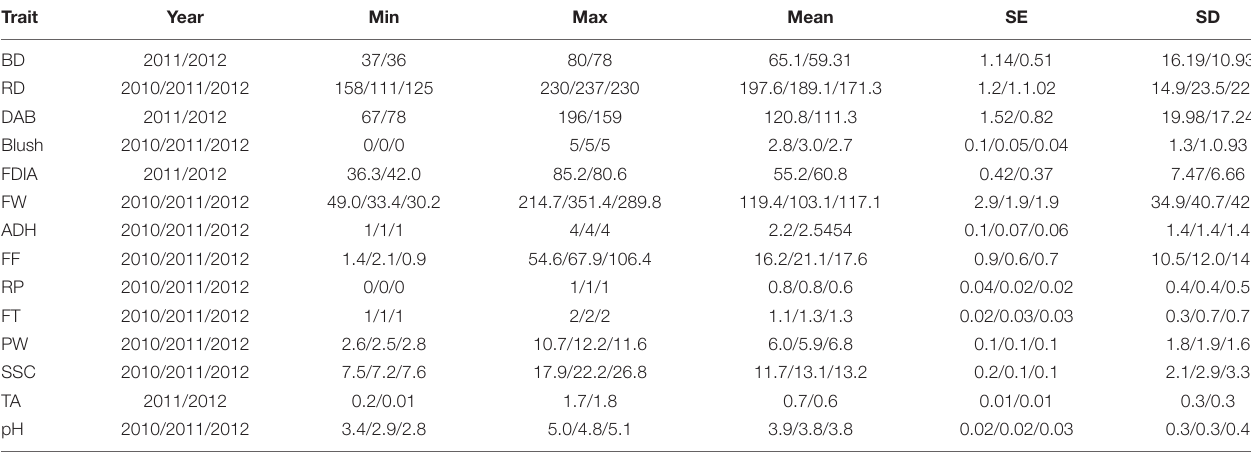
TABLE 1 | Descriptive analysis of 14 phenotypic traits observed in 620 individuals from three U.S. public fresh market peach breeding programs (Univ. of Arkansas, Texas A&M and Clemson Univ.) over three seasons (2010–2012).